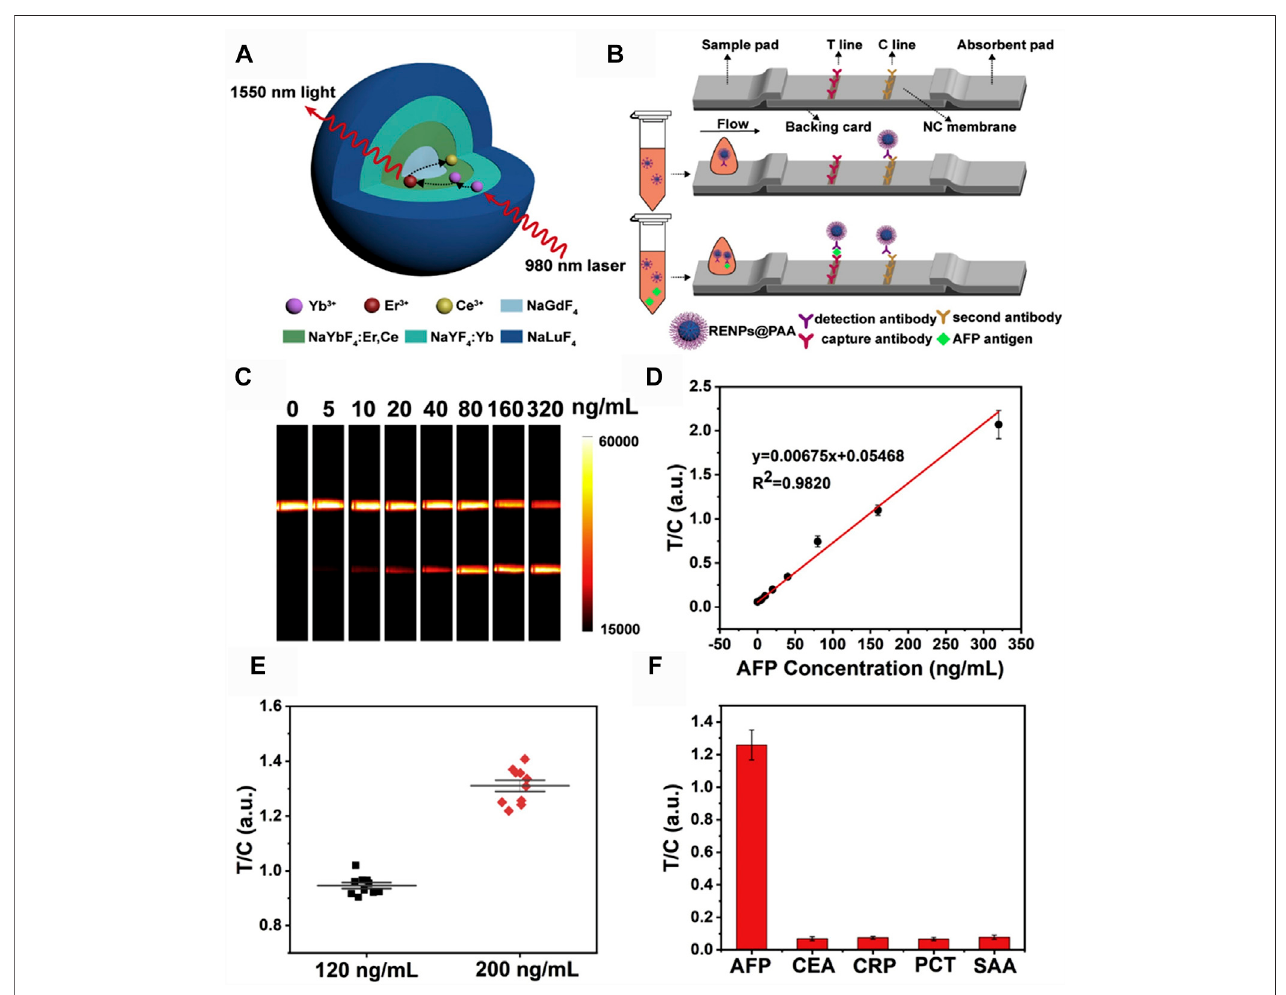
FIGURE 3 | NIR-II rare-earth nanoparticles for a lateral fl ow immunoassay in hemolysis (A) Structural design of the Yb, Er/Ce co-doped NIR-II rare-earth nanoparticles (Er,Ce-CSSS) with 1,550 nm emission under 980 nm excitation. (B) Schematic illustration of NIR-II rare-earth nanoparticles based lateral fl ow immunoassay platform (NIR-II LFA). (C) Strip images of AFP standards spiked in hemolysis by NIR-II LFA test. Exposure time was 100 ms. (D) The calibration curve for AFP detection in hemolysis. Error bars represent the stand deviations calculated from three separate experiments. (E) Reproducibility of NIR-II LFA for AFP detectionattheconcentrationsof120 ng/mland200 ng/ml. (F) Speci fi citytestofNIR-IILFAusingdifferentbiomarkers.TheconcentrationsofCEA,CRP,PCTandSAA were 10 times higher than that of AFP (reproduced from (Li et al., 2021) with permission from Elsevier